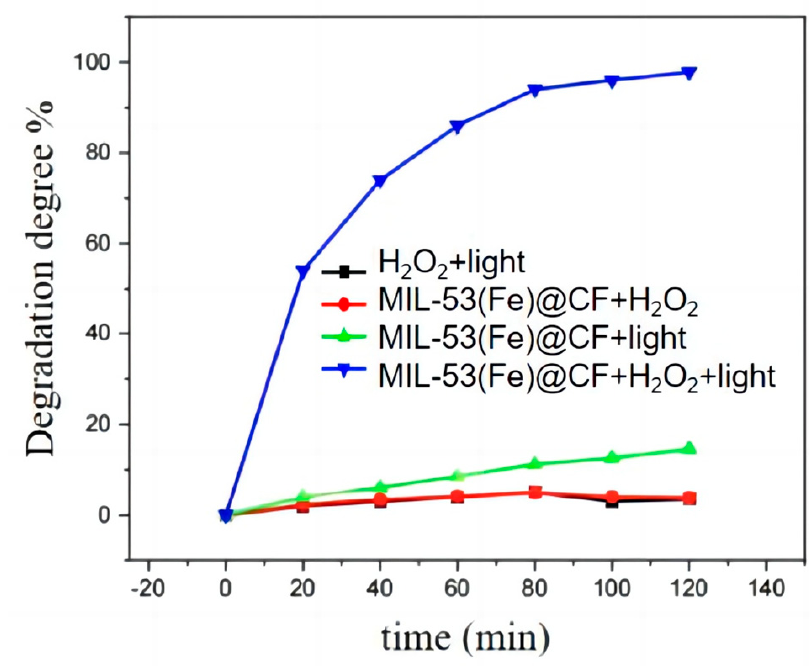
Figure 4. Effects of different conditions on photocatalytic oxidation of RhB. (Reactor: pH at 4.5, MIL-53(Fe)@CF photocatalytic membrane 150 mg, RhB 1 mg/L, H 2 O 2 1 mmol/L).